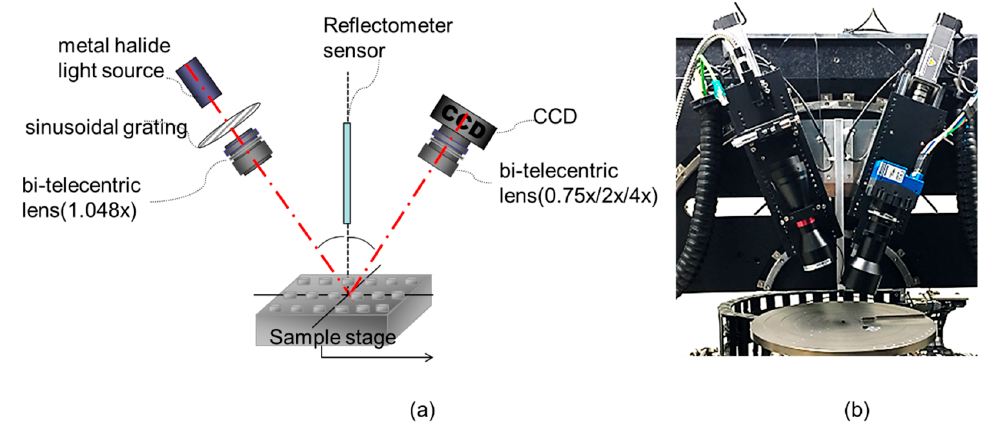
Figure 1. Telecentric 3D measurement system: ( a ) schematic diagram and ( b ) photo. A normal incidence reflectometer sensor was implemented on top of the sample to measure the PL thickness. The spectrum is measured in the broadband wavelength range of 375–780 nm. The normal incidence measurement largely relies on the interference be- tween light scattered from different locations on the target structure. The reflectance spec- trum typically has regular oscillations over a large wavelength range. The limiting factor in this case is the pixel resolution of the charge-coupled device (CCD) detector, which is about 0.4 nm at the upper wavelength limit of 780 nm. 2.3. Reference Plane Identification and Rotation Center Calibration To ensure that the sample is placed at the optimal focus position, the sample platform needs to be adjustable perpendicular to the z-axis and contain the center point of the cir- cular arc rail. Two laser point sources are mounted separately on the slider blocks, which can individually move on the same circular-arc rail. Both point toward the center of the circular motion orbit, as shown in Figure 2. Consider two virtual lines along the laser light that are perpendicular to the tangent of the circular arc; their intersection reveals the cen- ter point of the circular arc rail. The sample plane can be slightly adjusted up and down to reach the best focus position that minimizes the merged laser spots. Figure 2. Sample platform plane identification and rotation center calibration. The intersection of the two laser sources pointed toward the center of the circular motion rail indicates the best focus position for the sample plane. 2.4. Sample Details